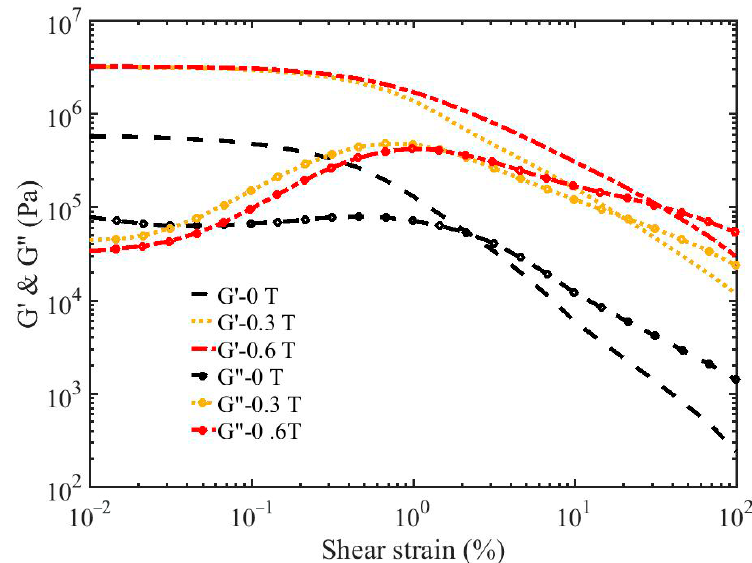
Figure 9. Dynamic shear moduli at the constant frequency.